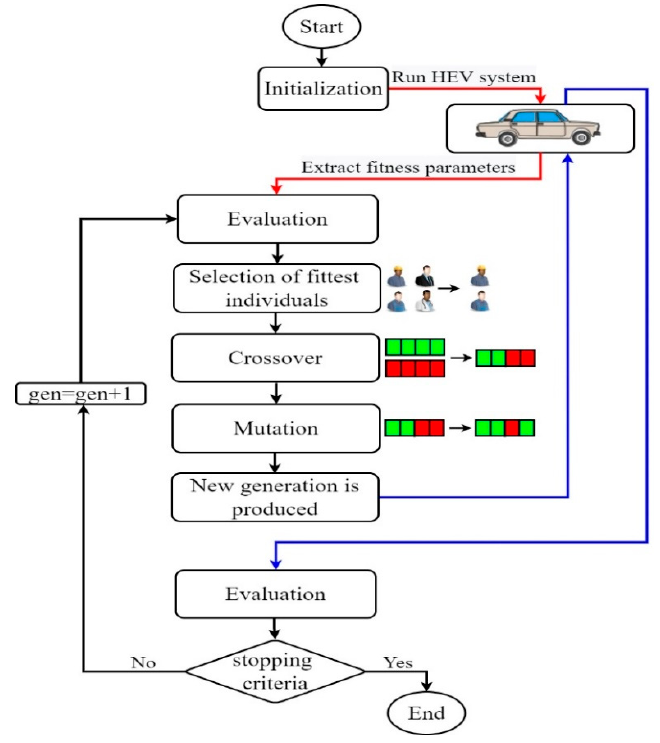
Figure 8. Genetic algorithm